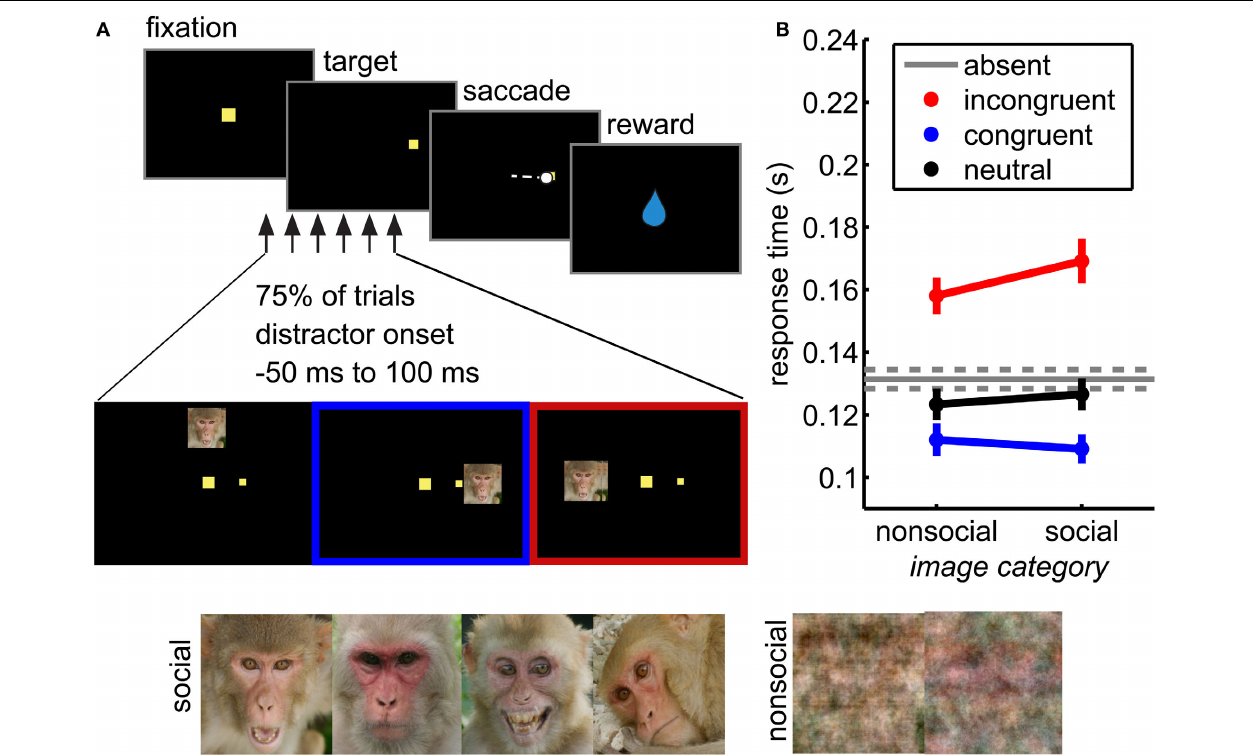
FIGURE 1 | Social distraction task. (A) Distractors were briefly flashed (for 67ms) during performance of a visually guided saccade task. These distractors were either social or non-social (phase scrambled) images. (B) Distractors interfered with response time in this task. Incongruent distractors (red) slowed responses, whereas congruent distractors sped